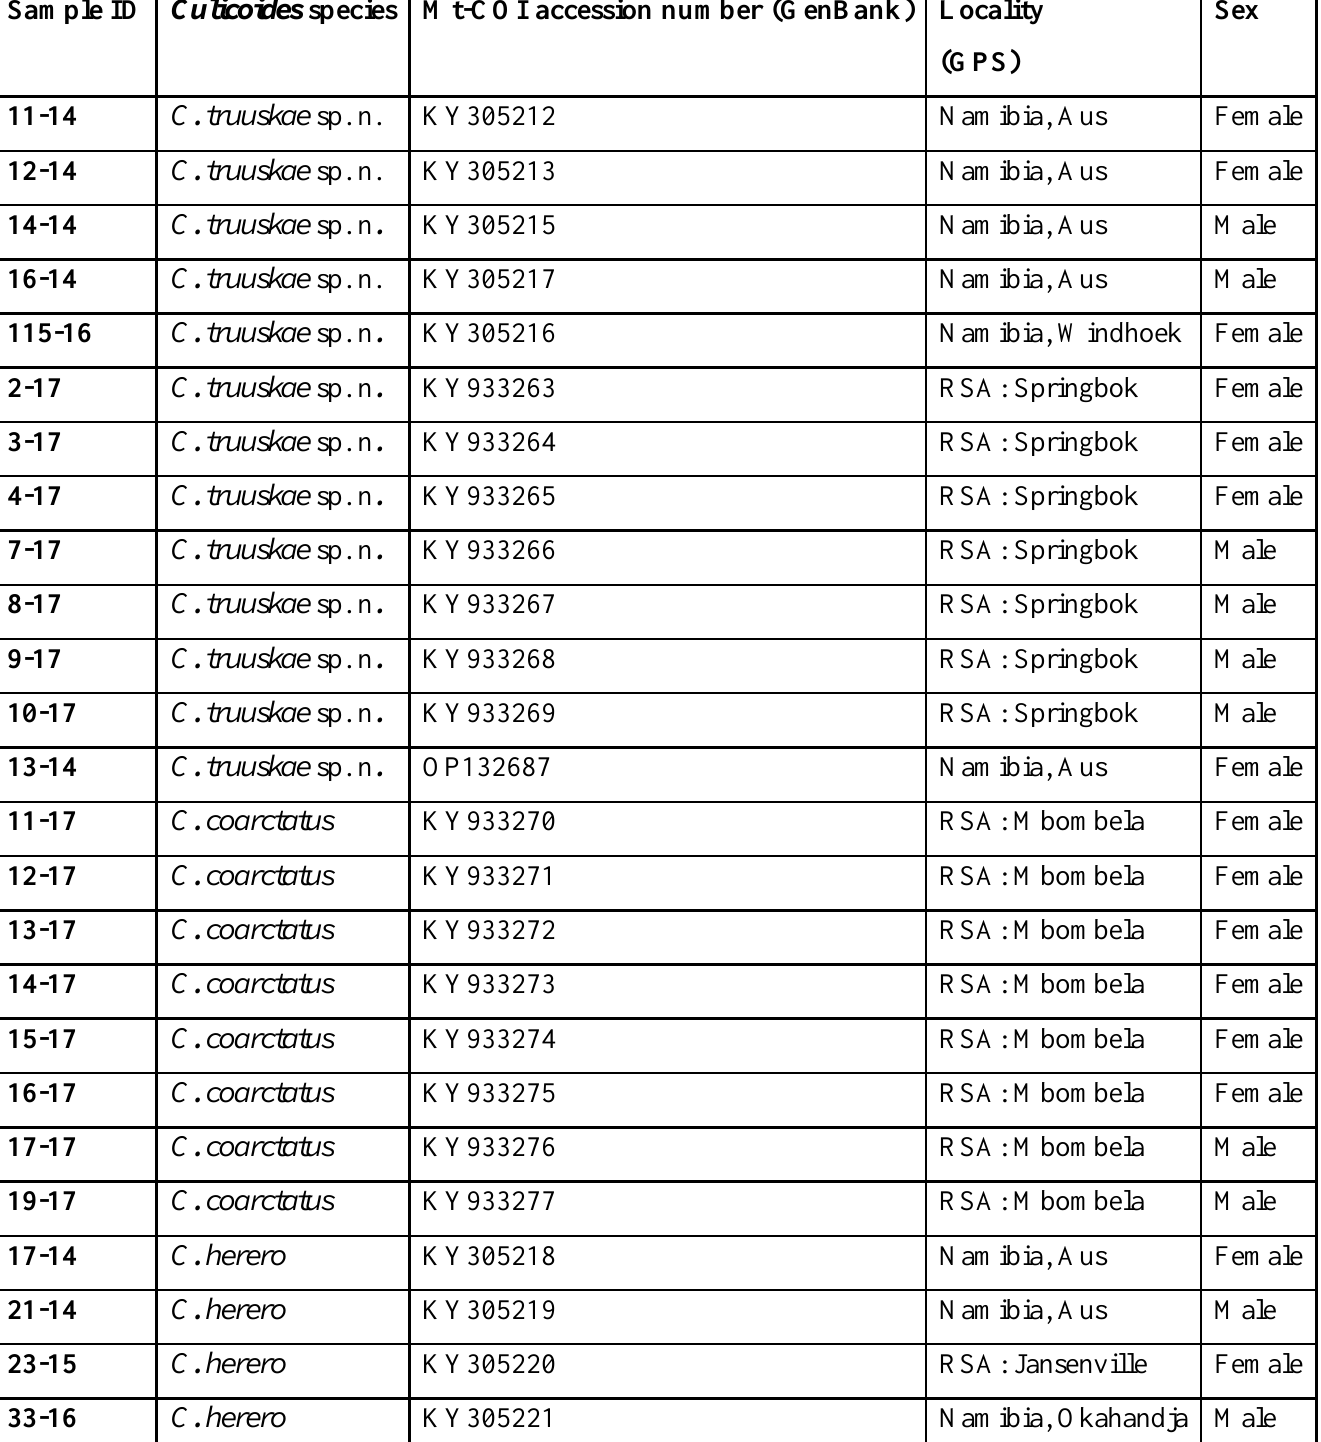
TABLE 1-A1 . Culicoides species sequenced as part of this study as well as sequences obtained from